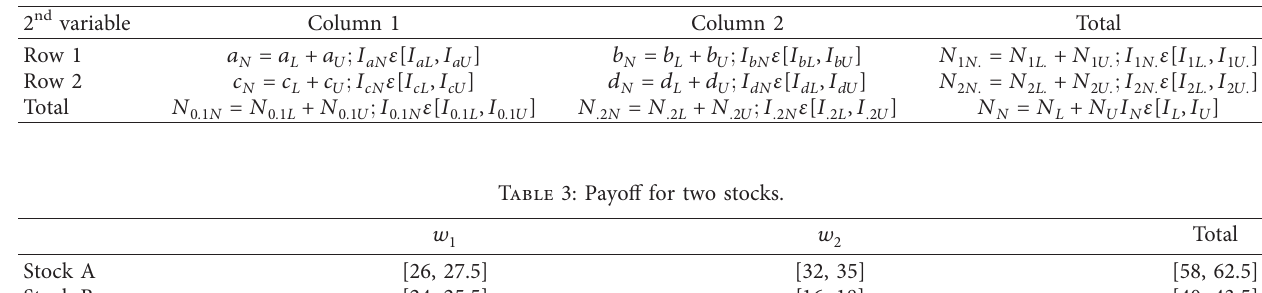
Table 2: Neutrosophic form of 2 × 2 contingency table 1 st variable.